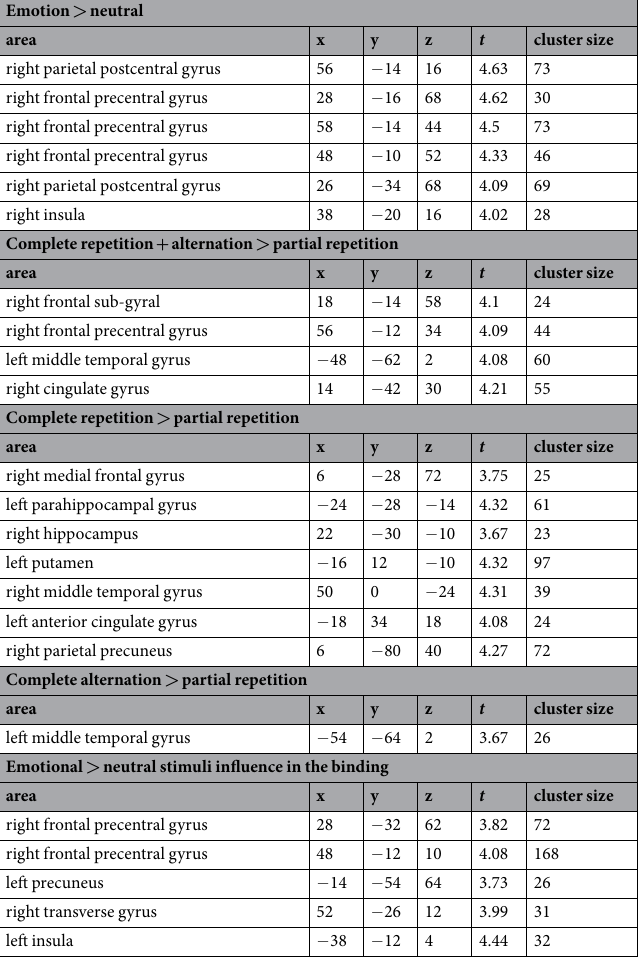
Table 2. Summary of the binding task image results. Binding task contrasts were thresholded at p < 0.001 (uncorrected) with a cluster extent of k = 23, corresponding to a Family-Wise Error (FWE) correction for multiple comparisons of p < 0.05 at the cluster